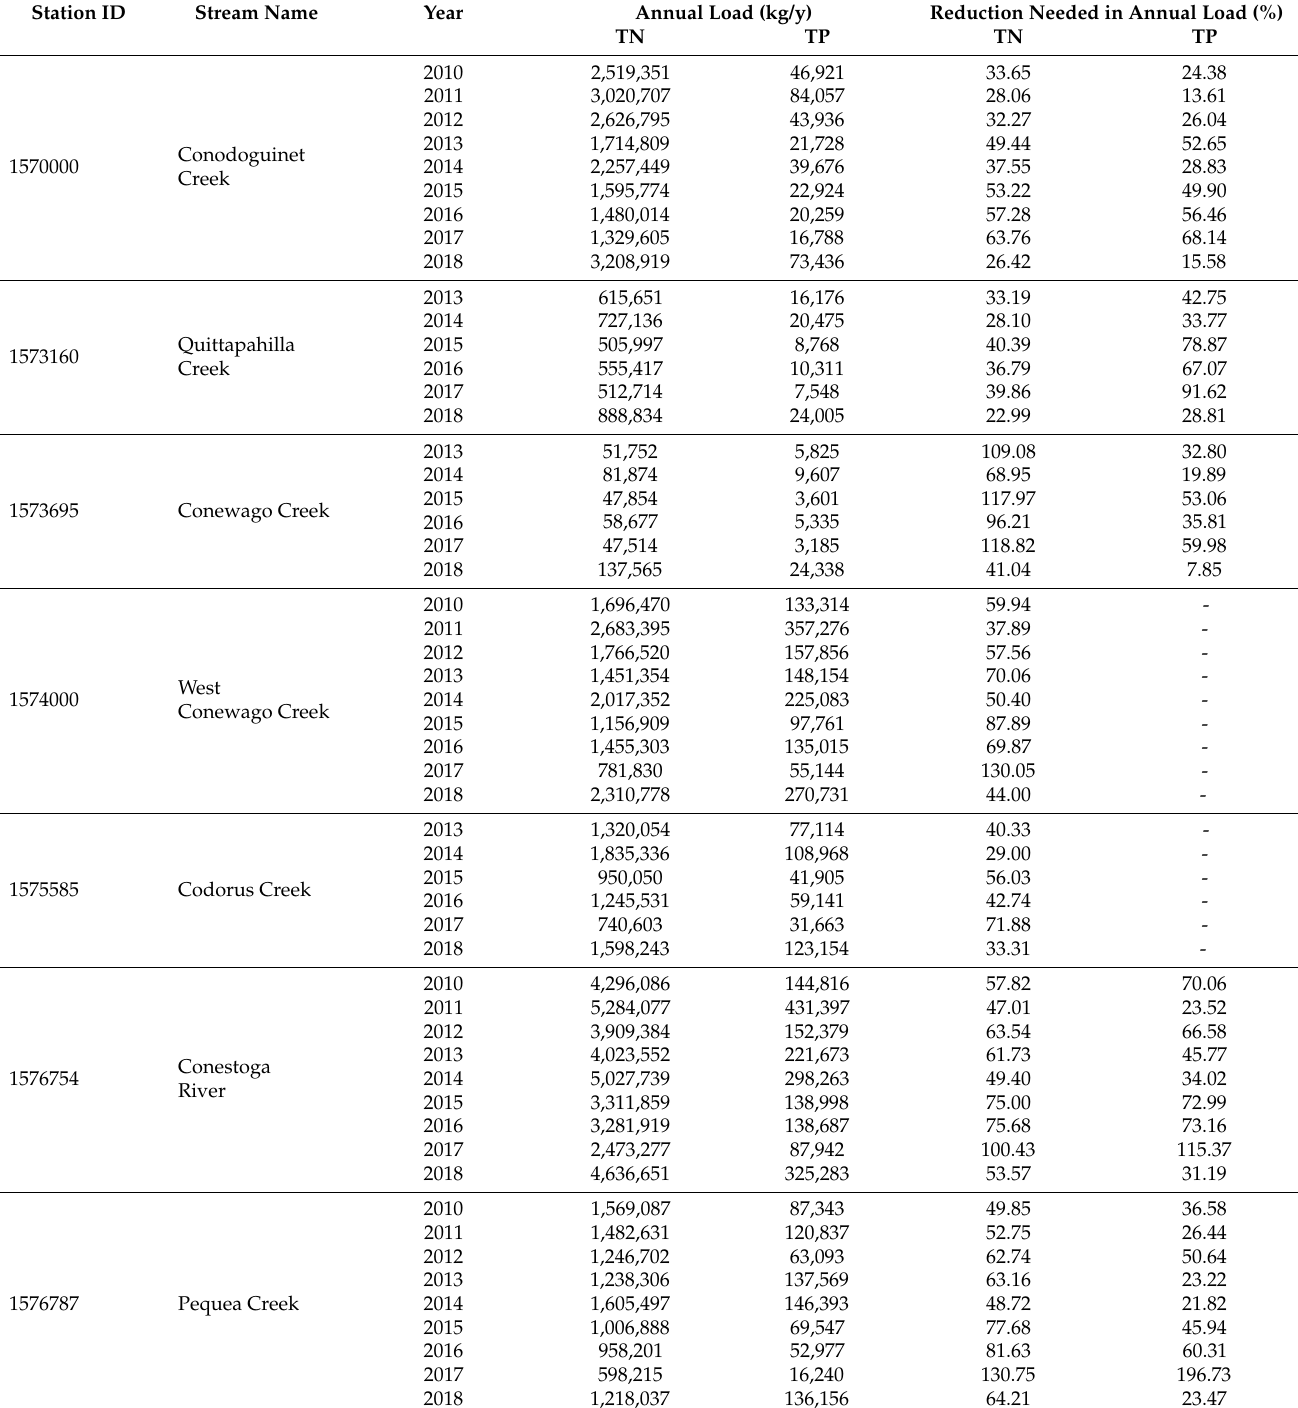
Table 2. Annual loads for total nitrogen (TN) and total phosphorus (TP) for each selected study site, along with the calculated percent reduction of TN and TP needed to meet the annual load-reduction goals provided in Table